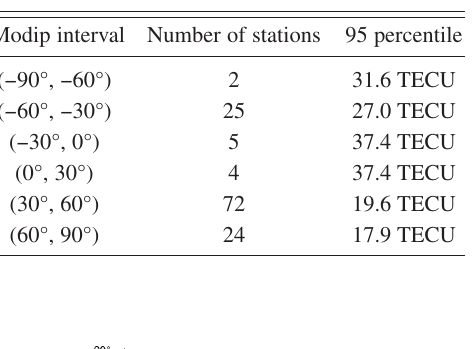
Table I. Statistical analysis summary for the day 27 March 2000: the first and second columns indicate the Modip interval with the corresponding number of IGS stations whose data were used to compute the cumulative distribution of the absolute value of the errors; the third column indicates the 95 percentile of the distribution of the absolute value of the errors.